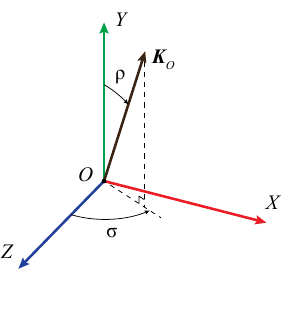
Figure 3. Angles describing the angular momentum with respect to the semi-orbital frame.